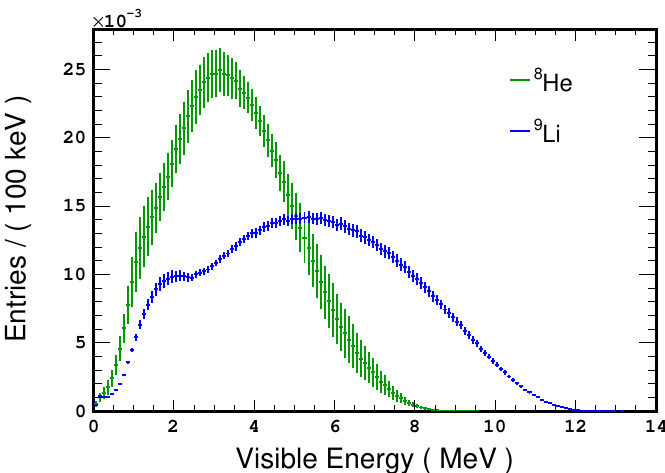
Figure 3 . Mean simulated 8 He and 9 Li spectra. The simulated spectra shown correspond to decays where the emitted neutron’s capture has been observed on H or Gd. Each spectrum is normalised to unity. The errors come from the covariance matrices associated with these